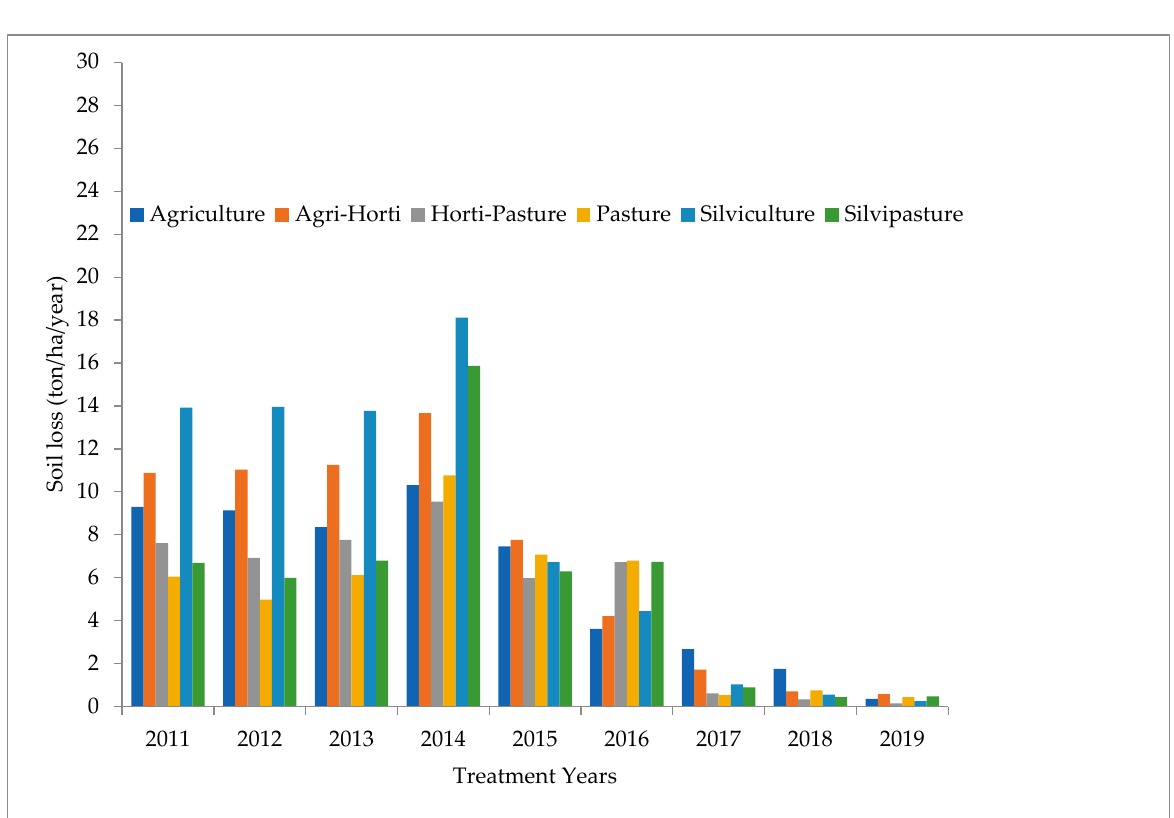
Figure 8. Yearly average annual runoff (mm) of each land use systems during 9 years of experiment (2011–2019). T 1 —Agriculture, Glycin max .; T 2 —Agri-Horti, Manilkara achras and Glycin max ; T 3 —Horti-Pasture, Emblica officinalis and Cenchrus ciliaris ; T 4 —Pasture, Cenchrus ciliaris ; T 5 —Silviculture, Accacia nilotica ; T 6 —Silvipasture, Accacia nilotica and Cenchrus ciliaris.